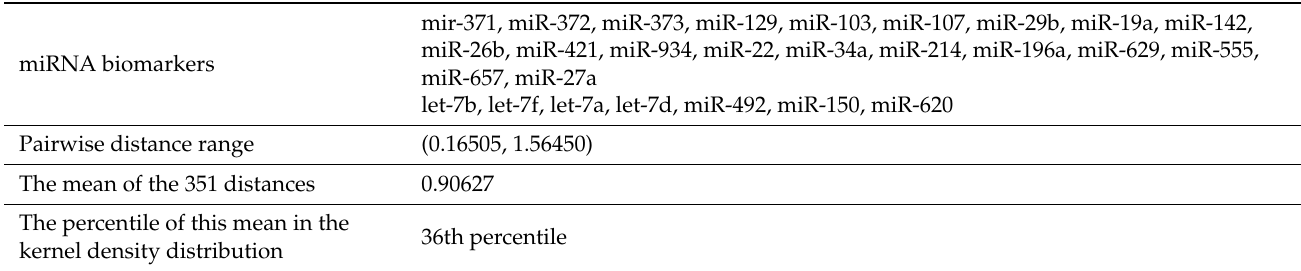
Table 3. The pairwise distance analysis of 27 miRNA biomarkers of anti-NMDA receptor encephalitis and tumors.